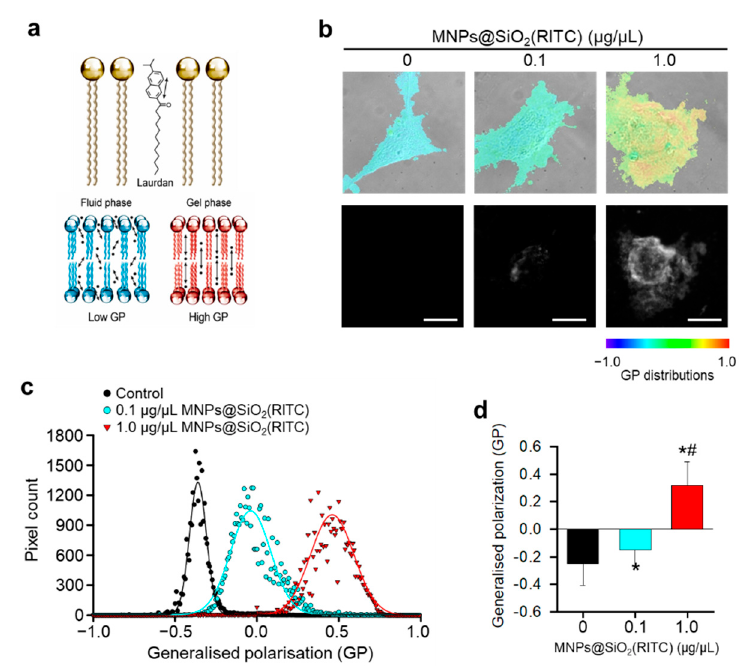
Figure 2. Laurdan generalized polarizations (GP) images and GP frequency distributions of hBM-MSCs treated with MNPs@SiO 2 (RITC) for 12 h. ( a ) Schematic of Laurdan for measuring membrane GP value. ( b ) Merged di ff erential interference contrast (DIC) and total internal reflection fluorescence microscopy (TIRFM) images of human bone marrow-derived mesenchymal stem cells (hBM-MSCs) in each upper panel. Distributions of magnetic nanoparticles incorporating rhodamine B isothiocyanate (MNPs@SiO 2 (RITC)) are indicated in each lower panel. GP distributions ranged from − 1.0 to 1.0. Scale bar = 2.5 µ m. ( c ) GP frequency distributions of cells. GP values of each pixel are represented as dots and were fitted to Gaussian distributions. ( d ) Total GP values. Data represent mean ± SD of three independent experiments ( n = 10). * p < 0.05 vs. non-treated control, # p < 0.05 for the comparison between cells treated with 0.1 and 1.0 µ g / µ L of MNPs@SiO 2 (RITC).